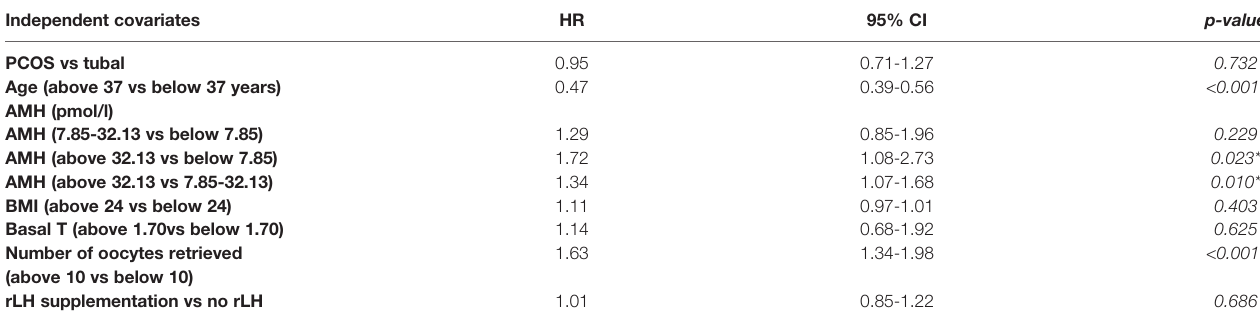
TABLE 3 | Multivariable Cox regression analyses of CLBRs. Independent